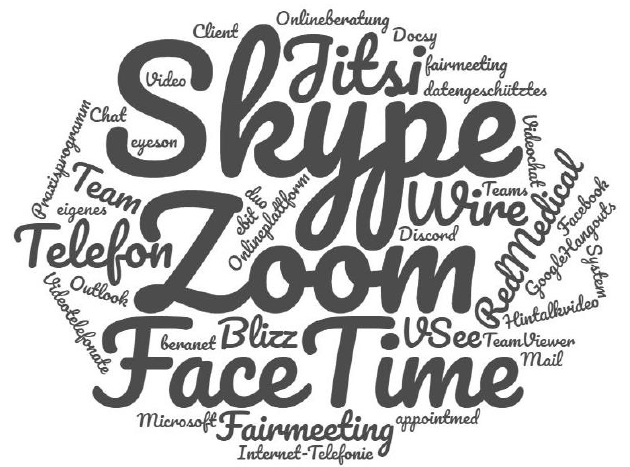
Figure 2. Word cloud on the answers to the free text question about the software used for psychotherapy via Internet.